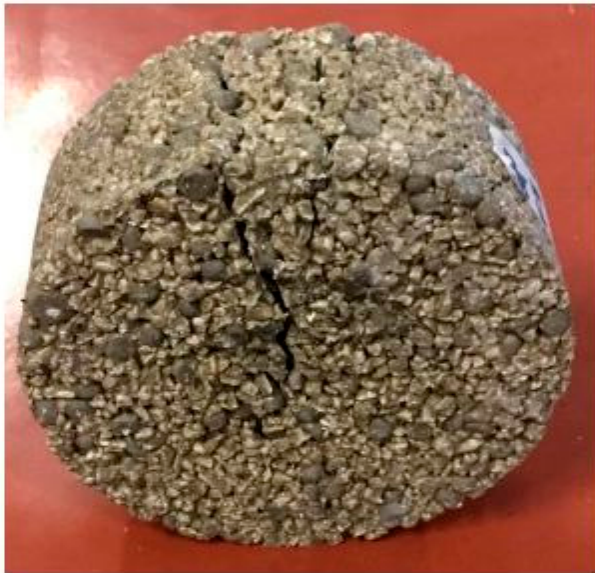
Figure 4. Gyratory sample with synthetic aggregates.